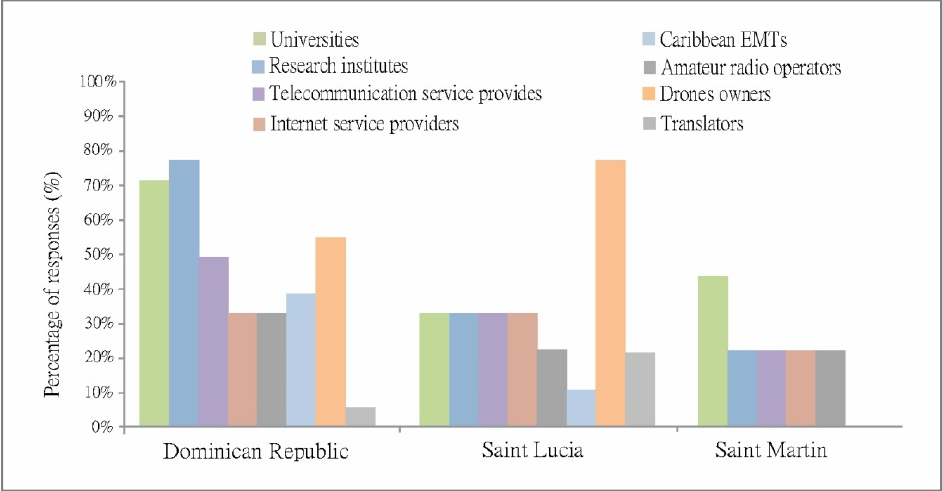
Figure 5. Missing stakeholders in EMT operations (Q11).